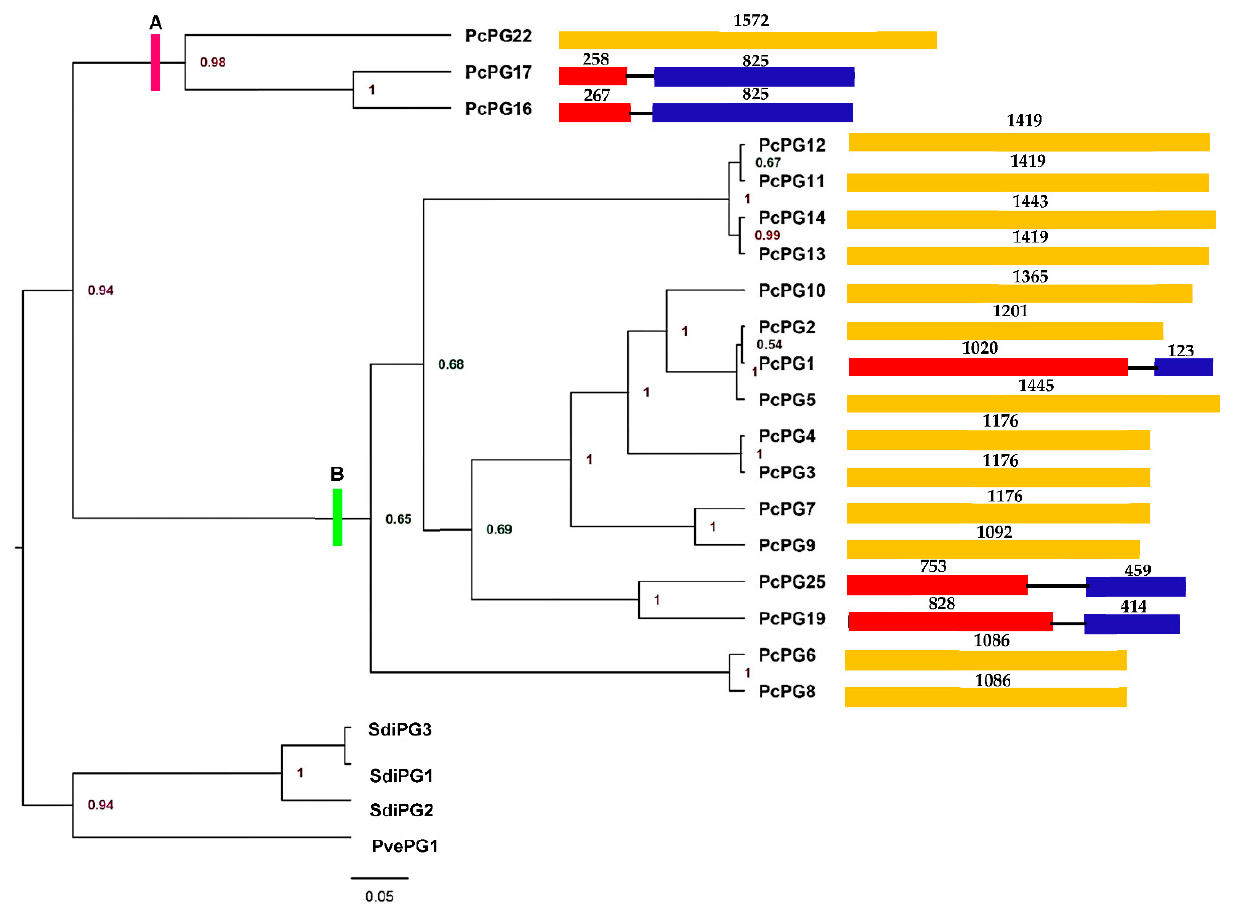
Figure 1. Phylogenetic tree and gene structure analysis of 19 full-length PGs from Phytophthora cinnamomi (Pc) with PGs from Saprolegnia diclina (Sdi) and Pythium vexans (Pv) species as outgroups. The tree was constructed using a Bayesian inference method implemented in BEAUti over a chain length of 50 million with sampling per 1000 states. The numbers in the nodes represent the posterior probabilities. Only posterior probability values > 0.9 were considered. PcPGs grouped into two distinct clades, Clade A (purple line partition) and Clade B (green line partition). In the gene structures, exons are represented by rectangles and introns by black lines. The numbers above the gene structures indicate the size of the exon regions in bp.